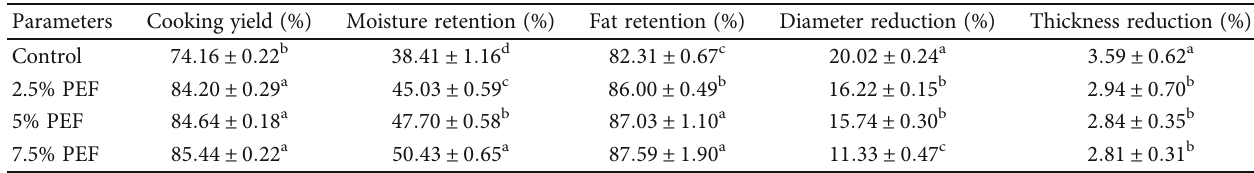
Table 3: Cooking properties of cooked beef patties with di ff erent concentrations of